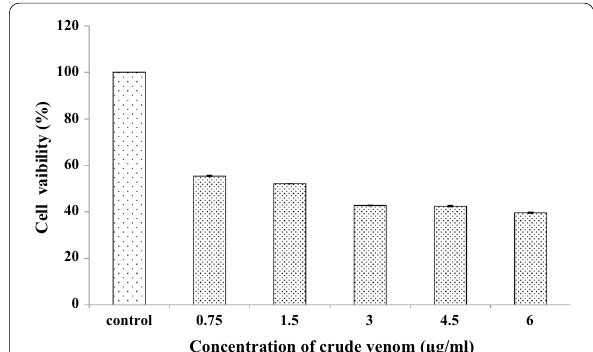
Fig. 2 Effect of crude venom from C. virgo on the cell viability of C6 cells at 24